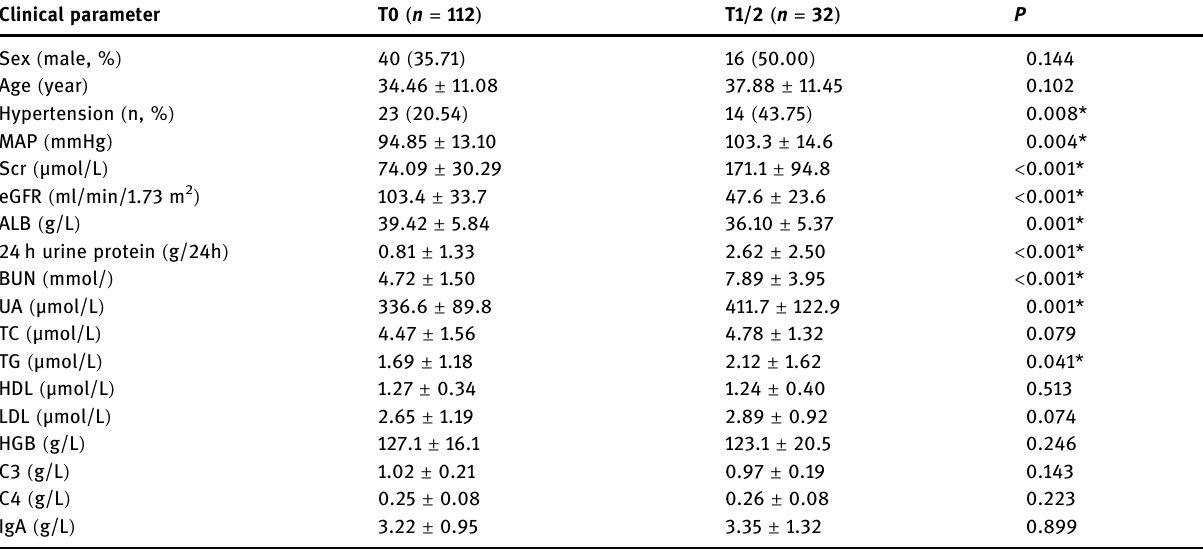
Table A4: Relationship of T score with clinical parameters of patients with IgAN Clinical